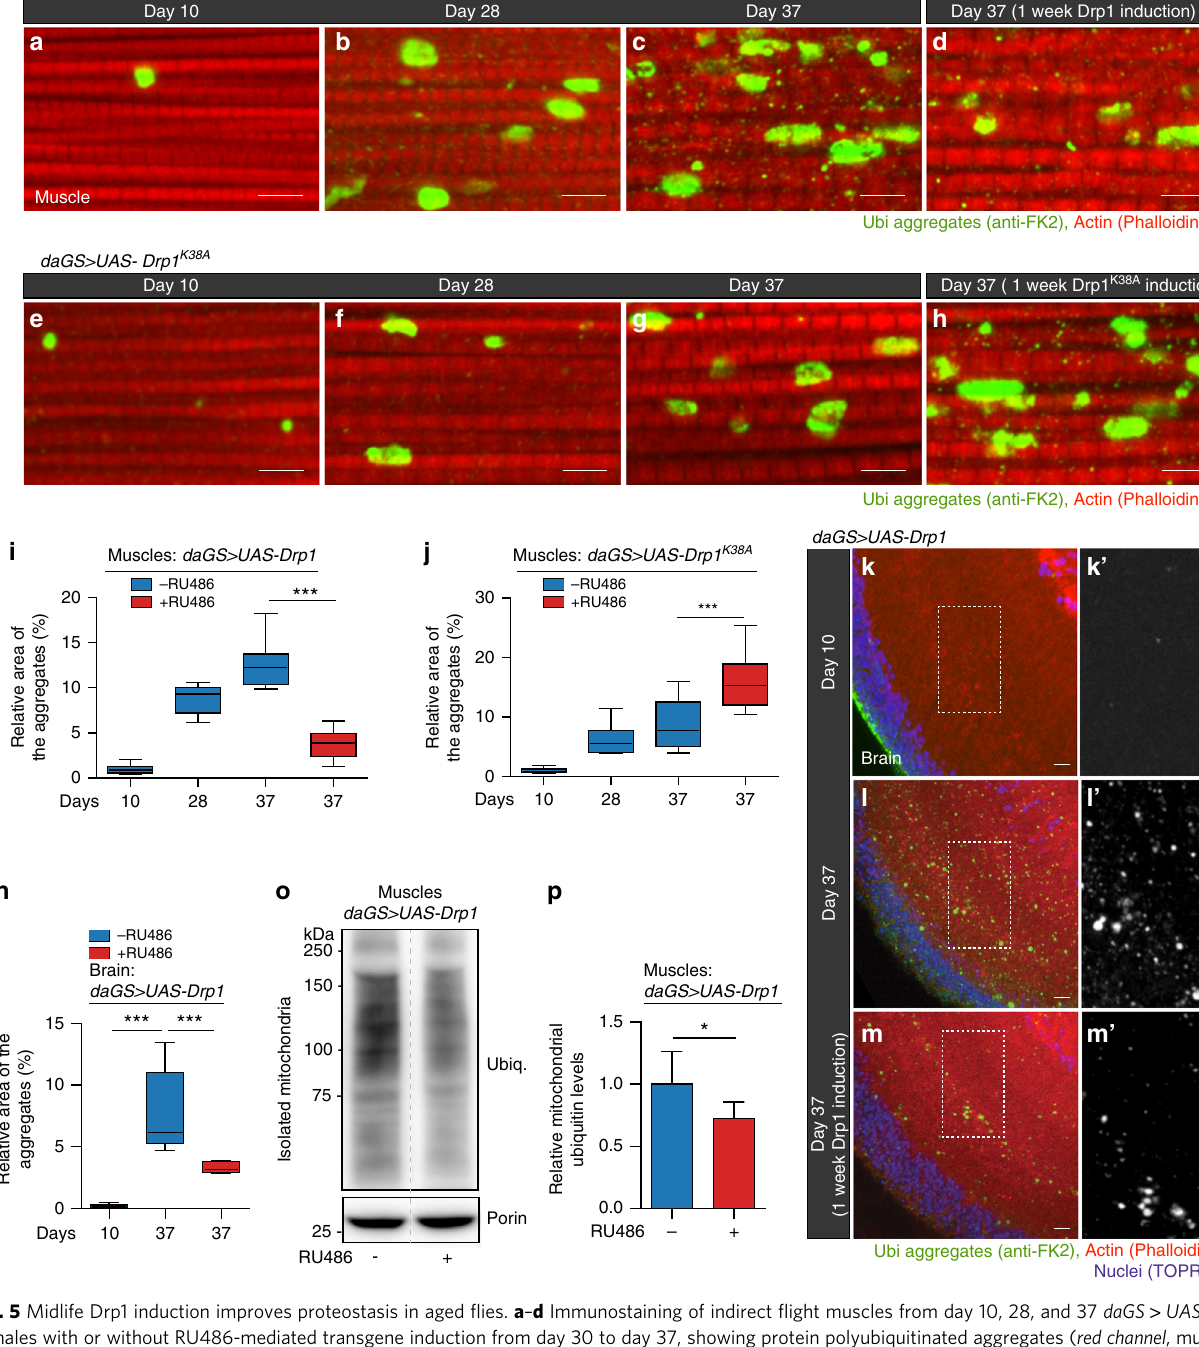
Fig. 5 Midlife Drp1 induction improves proteostasis in aged fl ies. a – d Immunostaining of indirect fl ight muscles from day 10, 28, and 37 daGS > UAS-Drp1 females with or without RU486-mediated transgene induction from day 30 to day 37, showing protein polyubiquitinated aggregates ( red channel , muscles stained with phalloidin/F-actin and green channel , antipolyubiquitin). e – h Immunostaining of indirect fl ight muscles from day 10, 28, and 37 daGS > UAS- Drp1 K38A females with or without RU486-mediated transgene induction from day 30 to day 37, showing protein polyubiquitinated aggregates ( red channel , muscles stained with phalloidin/F-actin and green channel , antipolyubiquitin). i Quanti fi cation of polyubiquitin aggregates in muscle as shown in a – d . n = 9 – 11 fl ies; *** p < 0.001; one-way ANOVA/Bonferroni ’ s multiple comparisons test. j Quanti fi cation of polyubiquitin aggregates in muscle as shown in 37 daGS > UAS-Drp1 females with or without RU486-mediated transgene induction from day 30 to day 37, showing protein polyubiquitinated aggregates ( red channel stained with phalloidin/F-actin; green channe l, antipolyubiquitin and blue channel , nuclei stained with TO-PRO-3). k ’ – m ’ Insets from k – m , respectively. n Quanti fi cation of polyubiquitin aggregates in optic lobe/brain as shown in k , m . n = 6 – 13 fl ies; *** p < 0.001; one-way ANOVA/Bonferroni ’ s multiple comparisons test. o , p Western blot o detection of total ubiquitin-conjugated proteins in isolated mitochondria from day 37 daGS > UAS-Drp1 females with or without RU486-mediated transgene induction from day 30 to day 37. Densitometry of ubiquitin blots p from mitochondrial pellet. n = 6 replicates (25 fl ies per replicate); *** p < 0.001; two-tailed Mann – Whitney test. Boxplots i , j and n display the fi rst and third quartile, with the horizontal bar at the median and whiskers showing the most extreme data point, which is no more than 1.5 times the interquartile range from the box. Bars p depict mean ± s.d. Scale bar is 5 µ m. RU486 was provided in the media at a concentration of 25 μ